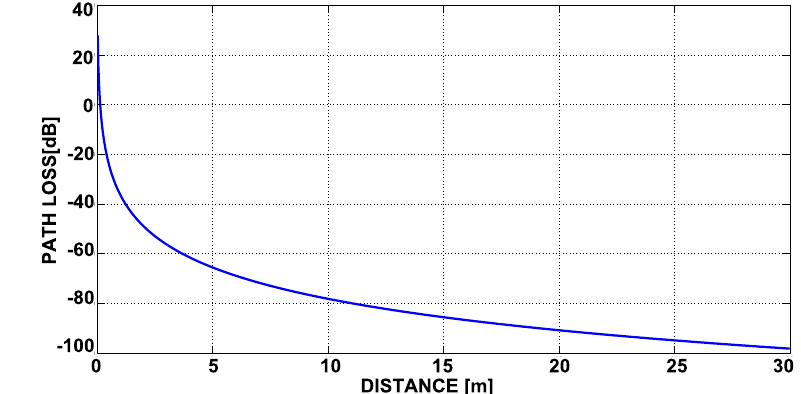
Figure 10. Path Loss